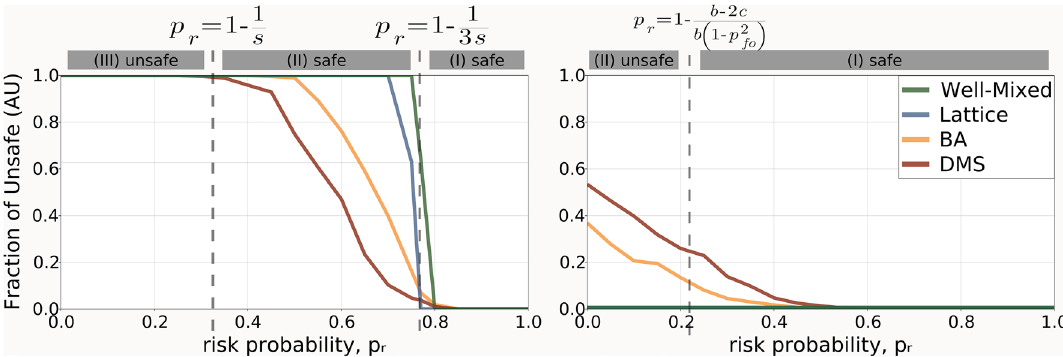
Figure 2. Heterogeneous networks moderate the need for regulation, shown by measuring frequency of unsafe developments across a range of different risk probabilities. The boundaries between zones are indicated with blue dashed lines, whereas the grey-highlighted texts on top of the figures indicate the collectively desired behaviour in each zone. The left panel reports the results for the early regime ( p fo = 0.5, W = 100 ), while the right panel does so for the late regime ( p fo = 0.6, W = 10 6 ) (parameter values are chosen for a clear illustration). Parameters: c = 1, b = 4, B = 10 4 , s = 1.5, β =